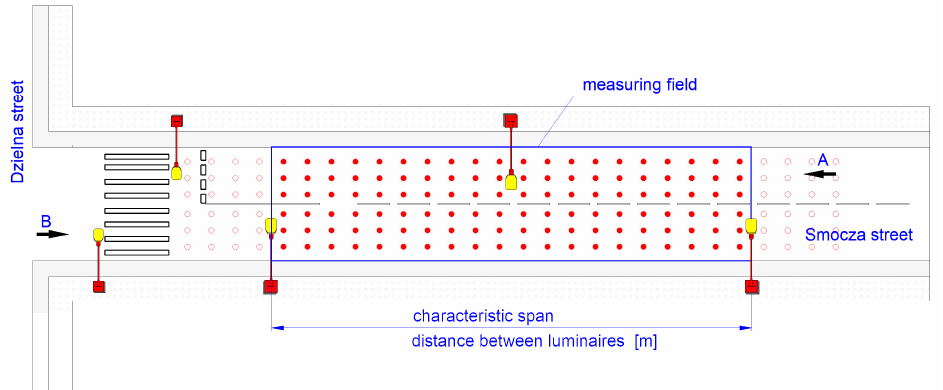
Figure 8. Measurement field in Section 24.